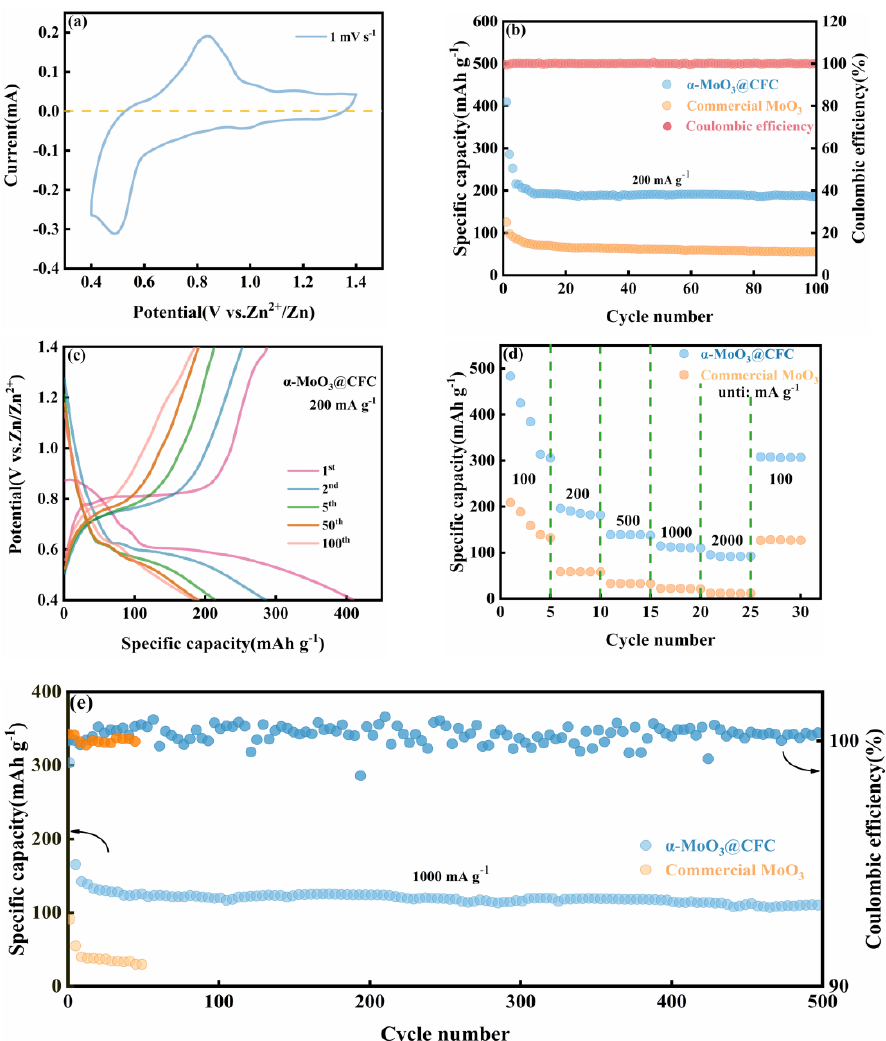
Figure 4. Electrochemical performance of α -MoO 3 @CFC and commercial MoO 3 . ( a ) Presented are 1